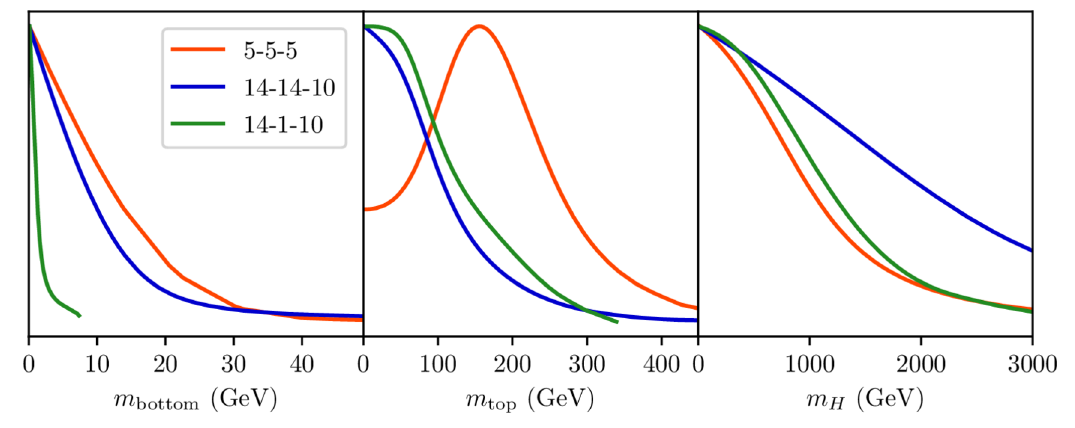
Figure 11. Priors for the bottom, top, and Higgs masses in all